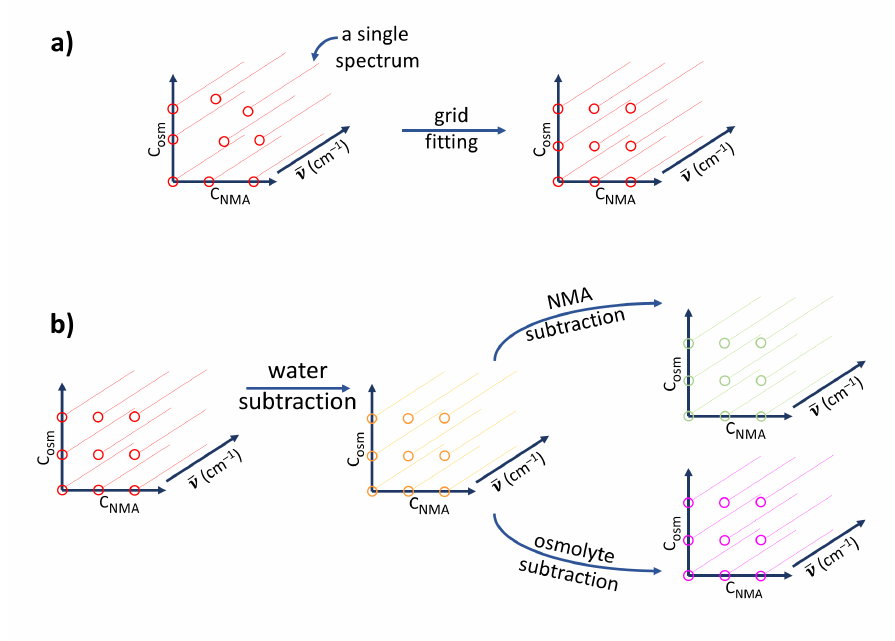
Figure 6. Preprocessing of the spectral series of ternary systems in which the variables are the wavenumber, NMA concentration, and osmolyte concentration. Single spectra are symbolized by colored lines starting with a circle (the wavenumber is arbitrary): ( a ) interpolation to a grid of points in the C NMA –C osm plane for each wavenumber (red); ( b ) interpolated spectra after water spectrum subtraction (yellow) are then separated into an NMA-free (green, after NMA spectra subtraction) or osmolyte-free (magenta, after osmolyte spectra subtraction) three-way series. All subtraction factors are calculated from the molar concentrations of the respective solutes or